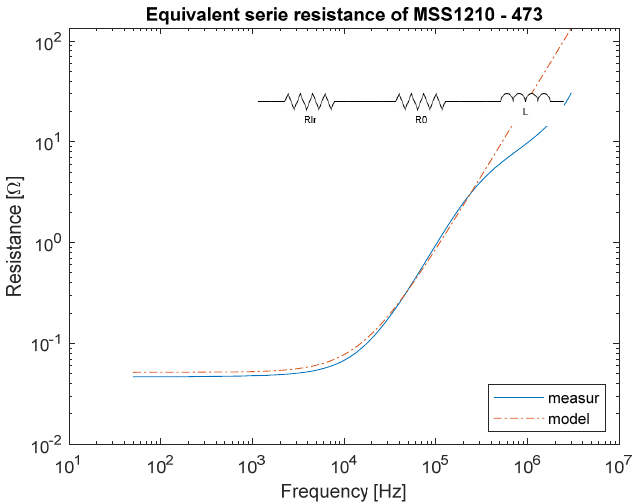
Figure 6. Evolution of the series resistance of the MSS1210-473 47 µH inductor with respect to frequency. Practical characterization in blue and equivalent model in dashed red.